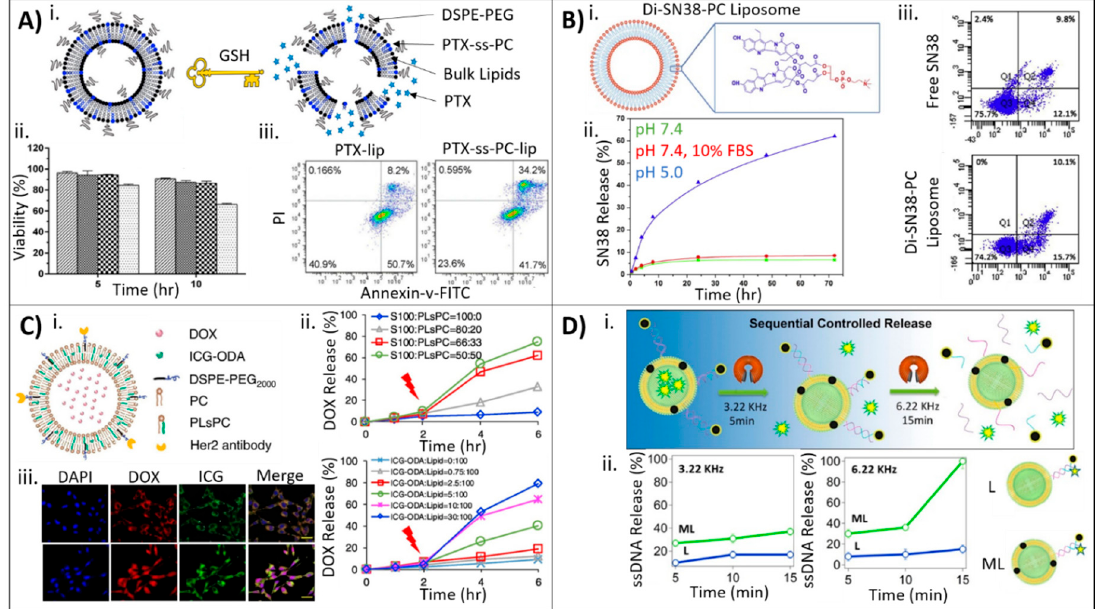
Figure 4. Examples of liposome–drug systems that incorporate drugs using covalent bioconjugation or a combination of bioconjugation methods. ( A ) ( i ) Schematic depicting liposomes composed of disulfide-containing lipid conjugate, PTX-ss-PC, demonstrating degradation and PTX release in the presence of GSH. ( ii ) Cellular viability of non-responsive liposomes without GSH (diagonal), responsive liposomes without GSH (small checkers), non-responsive liposomes with GSH (big checkers), and responsive liposomes with GSH (dots) demonstrating a decrease in MCF-7 viability over time for only responsive liposomes exposed to GSH. ( iii ) Flow cytometry analysis of annexin staining of MCF-7 cells (for apoptosis) after 48 h demonstrating increased apoptosis for responsive liposomes compared to non-responsive liposomes. Image adapted from Wang © Elsevier (2019) Ref. [56]. ( B ) ( i ) Schematic and scheme depicting liposomes fabricated with Di-SN38-PC prodrug. ( ii ) Cumulative SN38 release from Di-SN38-PC liposomes at pH 7.4 (green), pH 7.4 with 10% FBS (red), and pH 5.0 (blue) showing release only in acidic conditions. ( iii ) Flow cytometry analysis of apoptosis in MCF-7 cells at 36 h showing increased apoptosis for Di-SN38-PC liposomes compared with free SN38. Image from Du © Elsevier (2017) Ref. [58]. ( C ) ( i ) Schematic of responsive liposomes that degrade upon NIR excitation. ( ii ) DOX release over time as a function of liposome composition demonstrating that 33 mol % and 10 mol % of PLsPC lipid (top) and ICG-ODA (bottom) are required, respectively. ( iii ) MCF-7 cells treated with Her2-targeted responsive liposomes without laser (top) and with laser (bottom) stained for nuclei (blue), DOX (red), and ICG (green) demonstrating that NIR light increases DOX release. Scale bar, 20 um. Image adapter from Li © Elsevier (2018) Ref. [52]. ( D ) ( i ) Schematic illustration of magnetoliposomes showing sequential controlled release at di ff erent alternating magnetic fields. ( ii ) Release of ssDNA over time for magnetoliposomes (green) and blank liposomes (blue) at 3.33 kHz (left) and 6.22 kHz (right) showing that only magnetoliposomes, which contain iron oxide nanoparticles in the lipid bilayer, at 6.22 kHz release ssDNA. Image from Salvatore © American Chemical Society (2016) Ref. [66] .